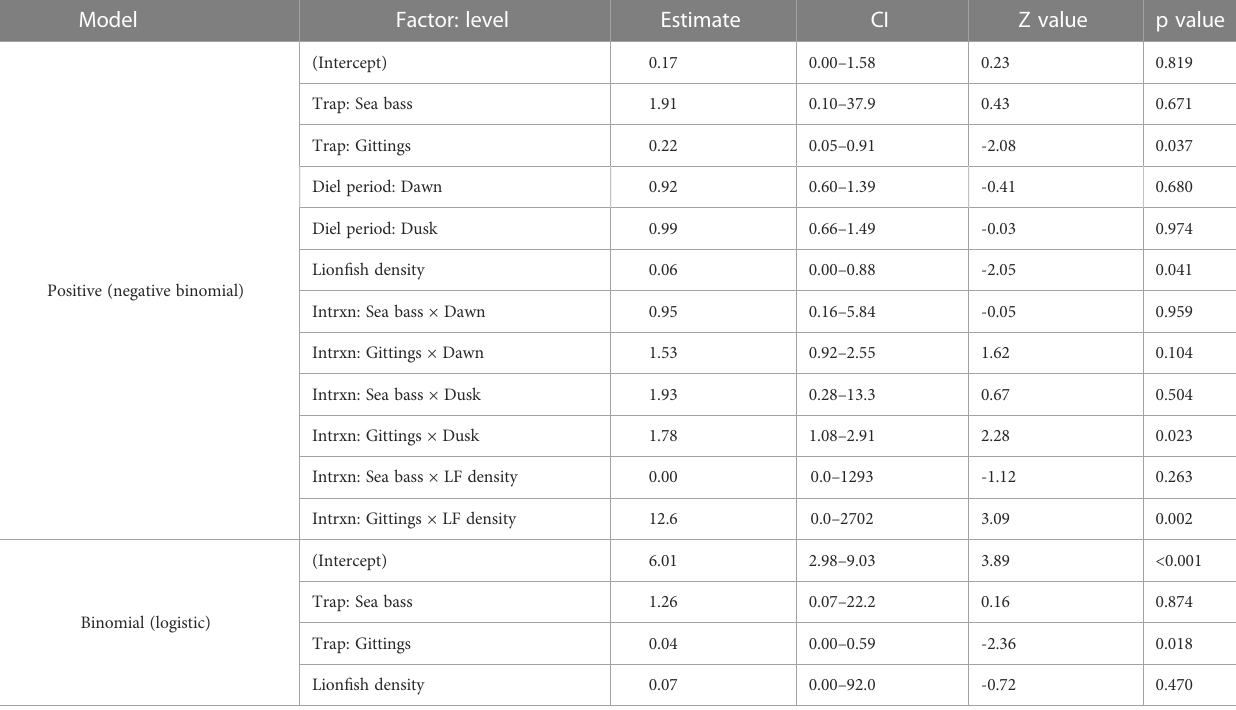
TABLE 3 Lion fi sh recruitment ( in situ observation of fi sh within the trap structure during deployment) model outputs estimated from time-lapse video fi sh counts.